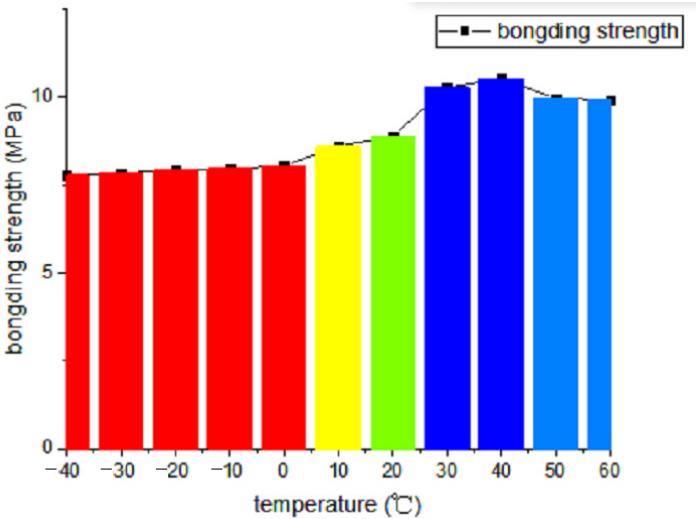
Figure 17. The test results of bond strength between polyurethane concrete and steel plate at different temperatures.